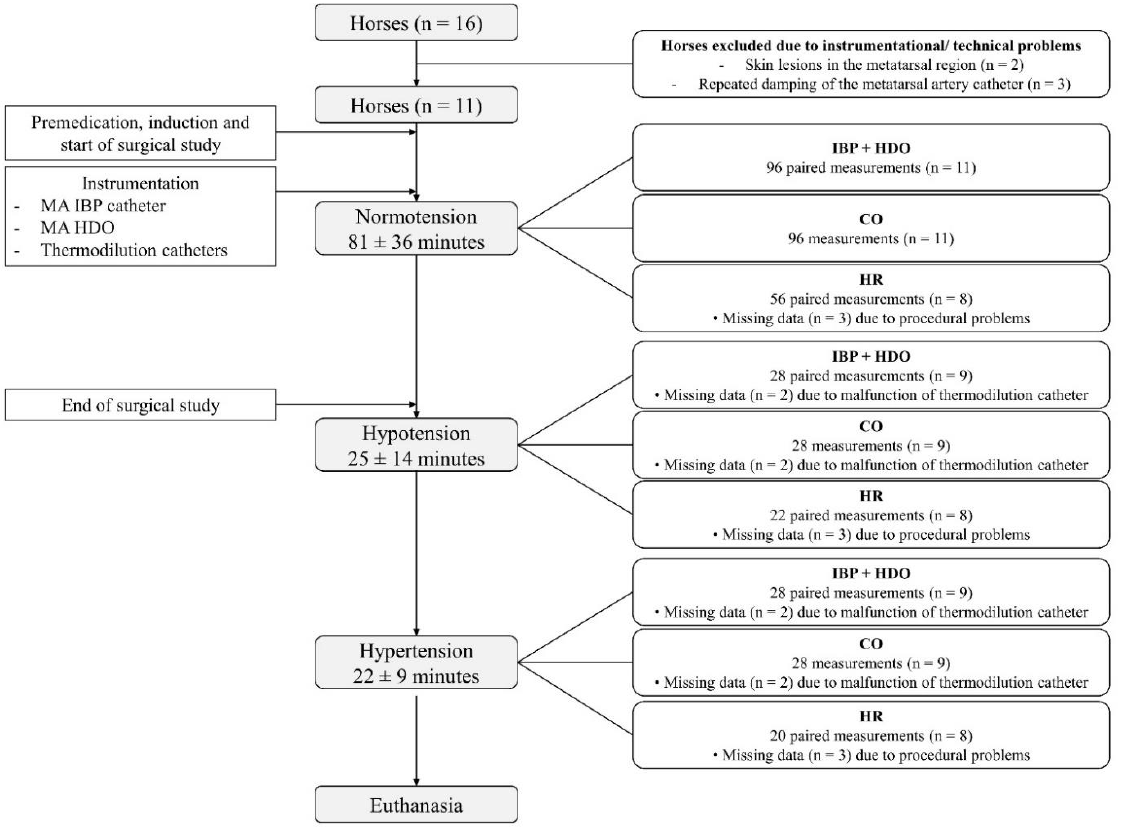
Figure 1. Consolidated Standards for the Reporting of Trials (CONSORT) flow diagram. Of 16 horses included in the terminal surgical trial, 5 horses did not meet inclusion criteria due to instrumentational or technical problems. Data of the remaining 11 horses were obtained and analysed. Invasive blood pressure (IBP), blood pressure obtained by high-definition oscillometry (HDO), cardiac output (CO), and heart rate (HR) were recorded simultaneously throughout the study. For normotension (mean arterial blood pressure (MAP) 61–119 mmHg), hypotension (MAP ≤ 60 mmHg), and hypertension (MAP ≥ 120 mmHg), the mean ( ± standard deviation) duration of measurements is given. The number of data recorded and included in the statistical analysis, as well as the number of missing data, is shown. Reasons for missing data were instrumentational, procedural, or technical issues. n = number of horses, IBP = invasive blood pressure, HDO = high-definition oscillometry, MA = metatarsal artery, MAP = mean arterial pressure.